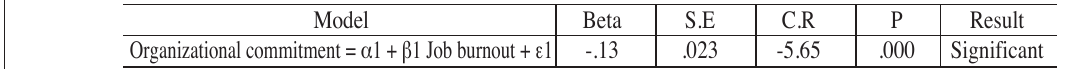
Job Burnout and Organizational Commitment